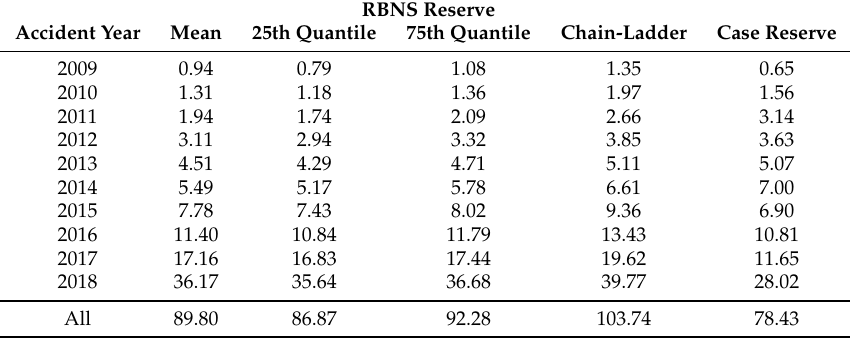
Table 8. Simulations results and Chain-Ladder (CL) estimates (in MM) - a new re-calibration of NNs and a new simulation